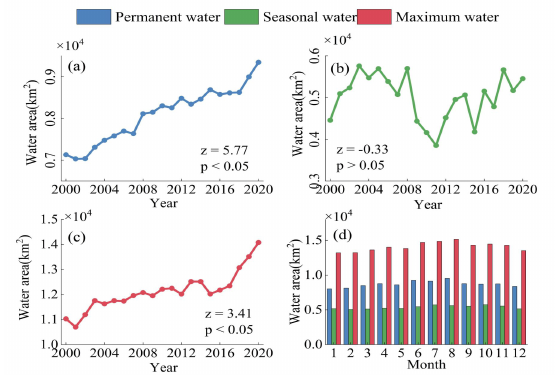
Figure 6. Annual and monthly variation of surface water in the Yellow River Basin from 2000 to 2020. The z value in the Figure 5(a-c) is the result of the MK (Mann-Kendall) test, whose symbol indicates the direction of the trend and the value indicates the magnitude of the trend. p<0.05 indicates that the MK test result is significant.